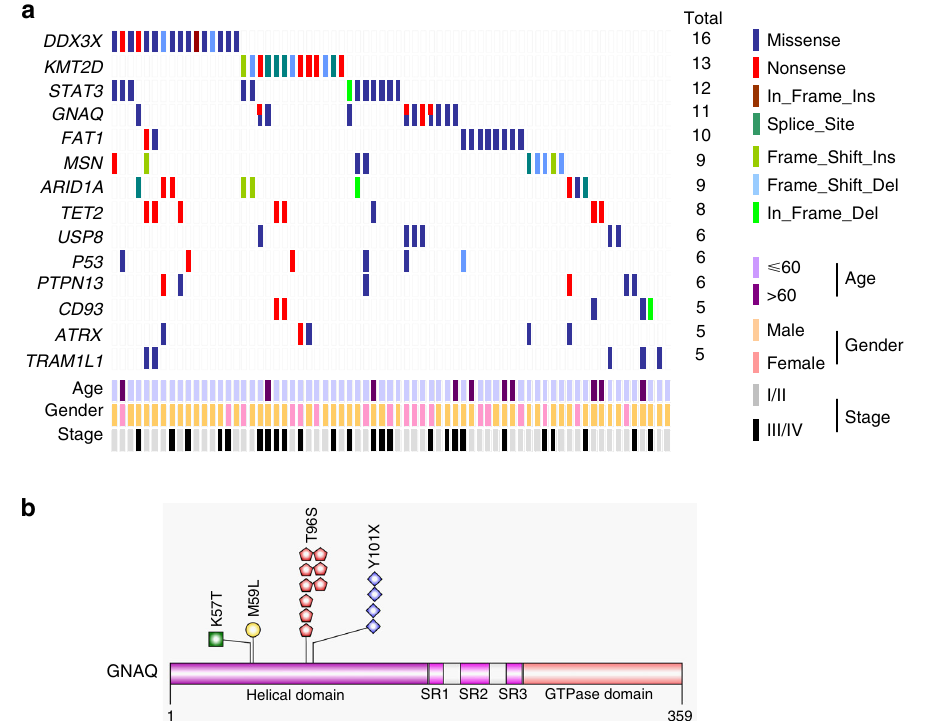
Fig. 2 Frequently mutated genes. a Fourteen frequently mutated genes are ranked according to the frequency of mutations. Samples are displayed in columns. Gene mutations are shown in different colors according to the type of alteration. The total number of patients with mutations in each gene is listed on the right. b Mapping of GNAQ mutation sites in the total NKTCL patient cohort. Functional domains of the altered proteins are based on the UniProt